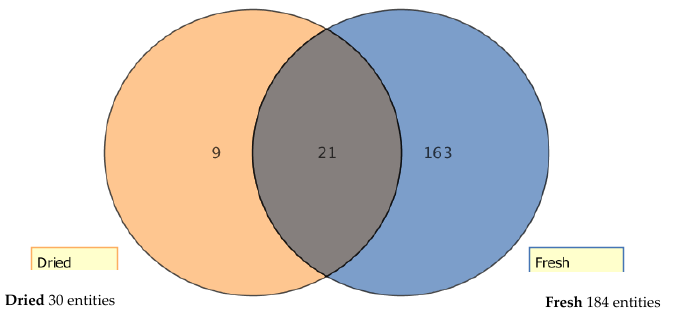
Figure 3. Venn diagram of flavonoids quantified in fresh and dried cultivars, and total flavonoids shared under both conditions.